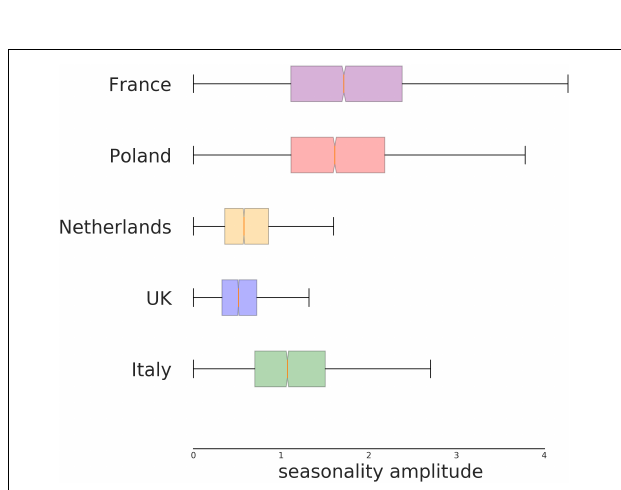
FIGURE 5 | Representation of the effect of the correction on the NU-AGE index at T0 and T1 for both control and NU-AGE diet intervention group. Each arrow represents a subject, starting from the non-corrected values at (T0, T1) and arriving at the post-correction values. Longer arrows represent a stronger correction, while the barely visible arrows at the center of each cloud represent subjects whose NU-AGE index has not been corrected. The diagonal red line represents identical NU-AGE index before and after the intervention study.